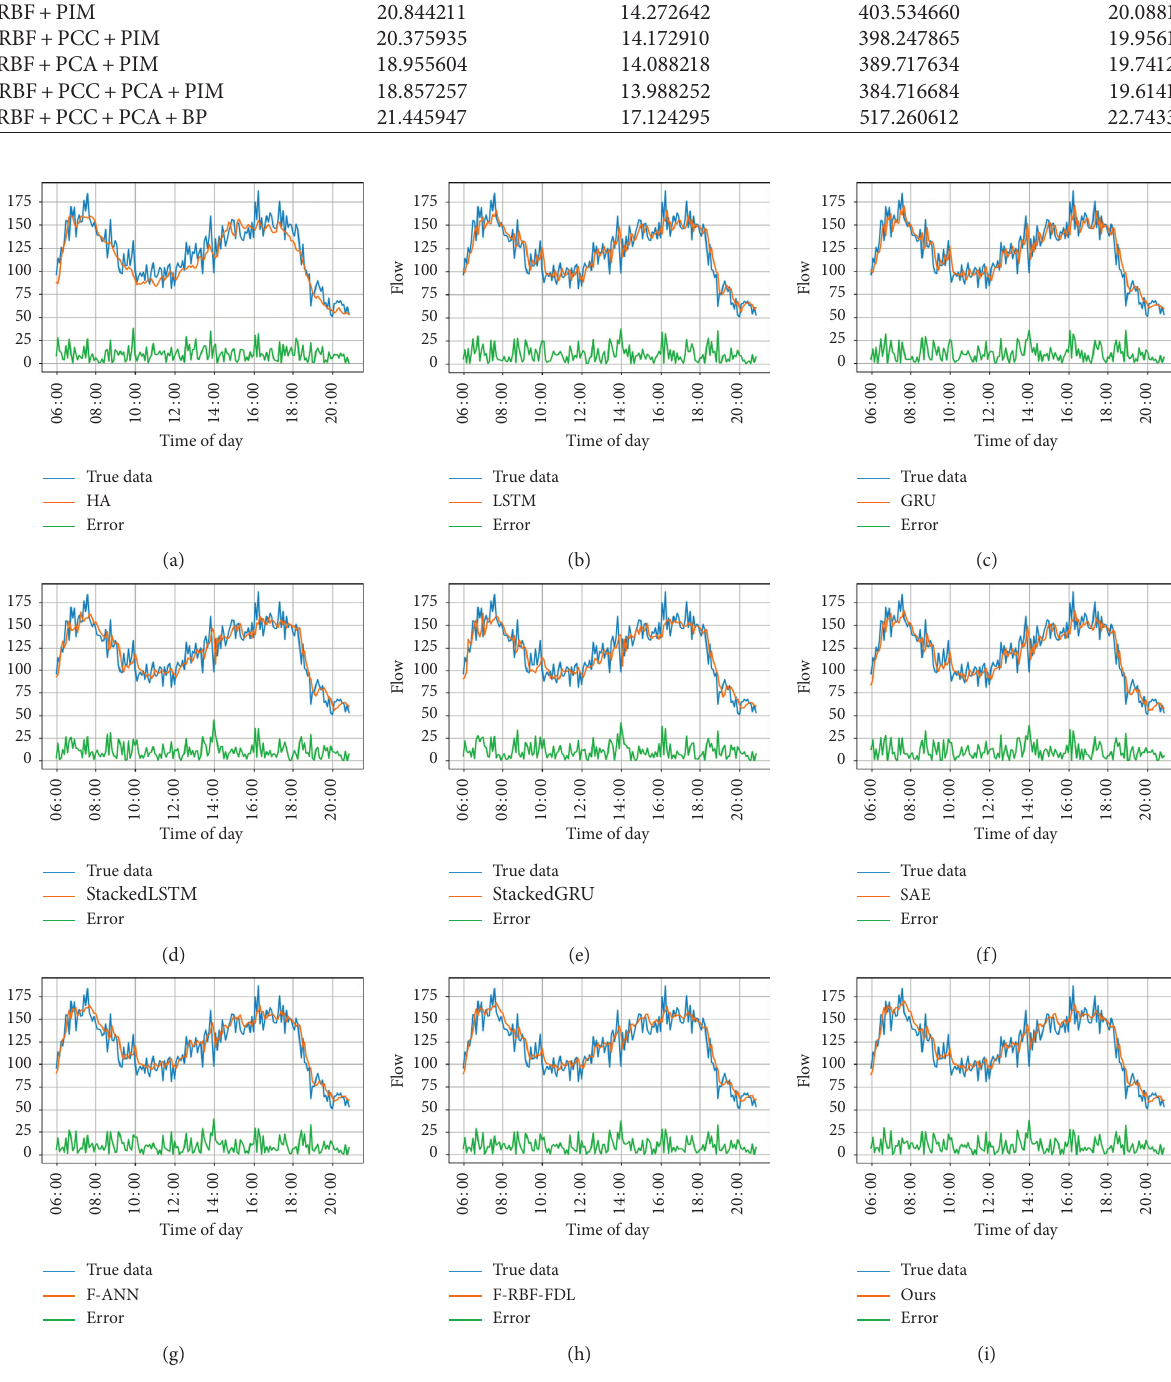
Figure 8: Performance comparison of different models. Prediction with traffic data only: (a) HA. (b) LSTM. (c) GRU. (d) StackedLSTM. (e) StackedGRU. (f) SAE. Prediction with both the traffic data and weather data: (g) F-ANN. (h) F-RBF-FDL. (i)